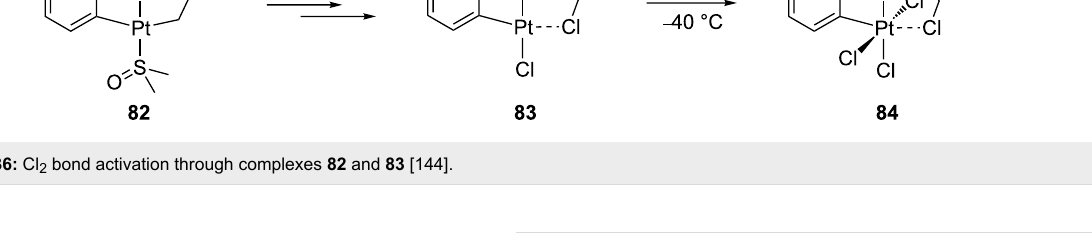
agostic species A9 , the resulting CH 2 Cl group is interacting with the open coordination site. Further reaction of 83 with PhI·Cl 2 forms the oxidation product 84